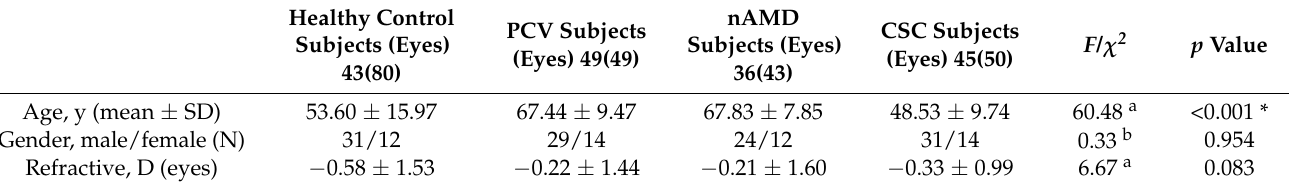
Table 1. The demographic characteristics of all the enrolled subjects.